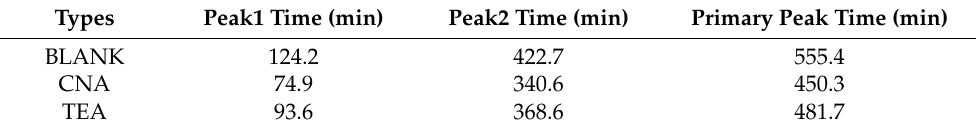
Table 3. Characteristic time of resistivity differential curve with different early strength agents.